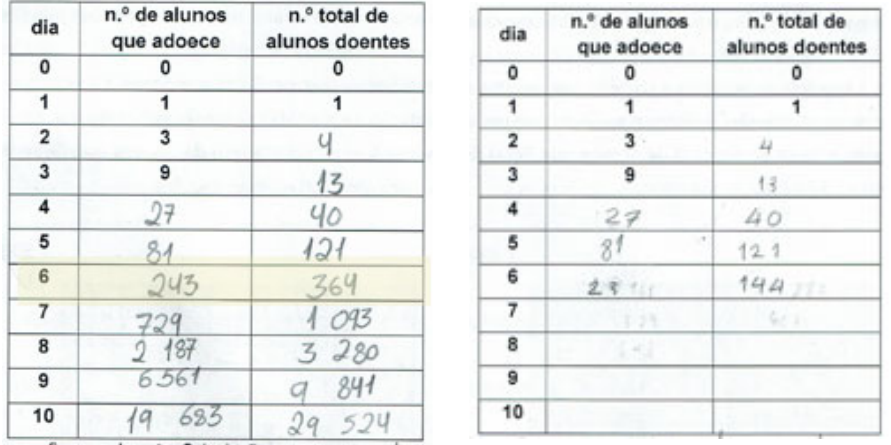
Figure 4. Each student infects three colleagues. During this task, teacher Elisa observed some excitement in her students.